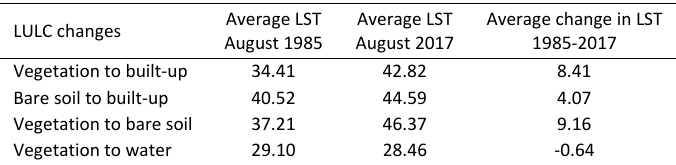
Fig. 5. LST changes from 1985 to 2017 in Fig. 5: LST changes from 1985 to 2017 in Isfahan Table 4: LST (°C) with respect to LULC changes Table 4.LST (°C) with respect to LULC changes